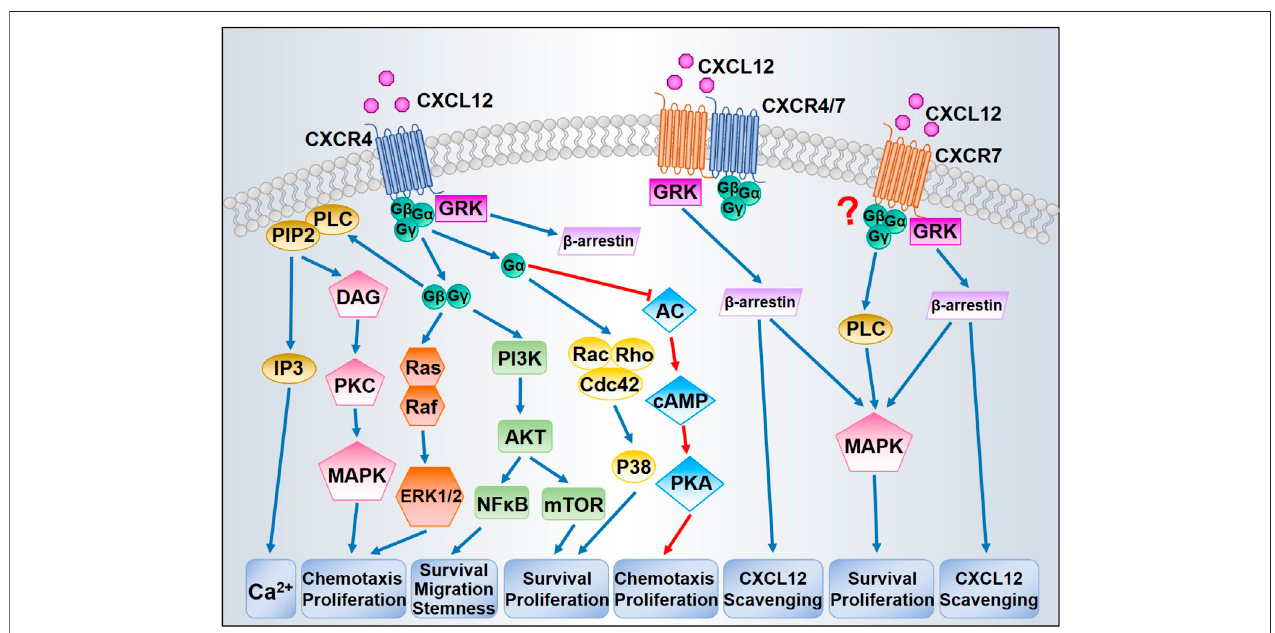
FIGURE 1 | Proposed CXCL12/CXCR4/CXCR7 signaling pathways. After binding with CXCL12, CXCR4 activates downstream signaling through G proteins and GRKs. Dissociation of the G protein complexes subsequently triggers MAPK, ERK1/2, and AKT signaling pathways, thereby promoting cell survival and proliferation. GRKs mainly induce the recruitment of β -arrestin leading to CXCR4 internalization. CXCR7 could induce β -arrestin independently or through CXCR4/CXCR7 heterodimer, resulting in MAPK activation and CXCL12 scavenging. The question mark indicates that whether CXCR7 is coupled to G protein has been in debate.